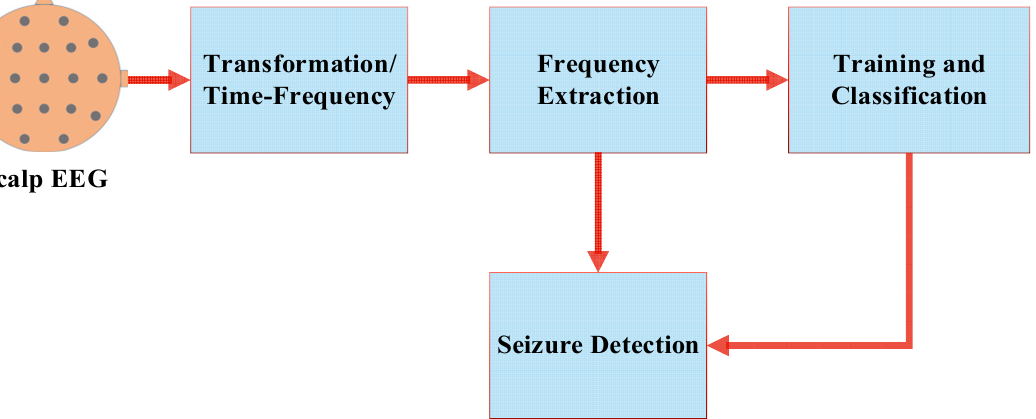
Figure 1. Common stages of automatic seizure-detection process based on feature extraction and classification.